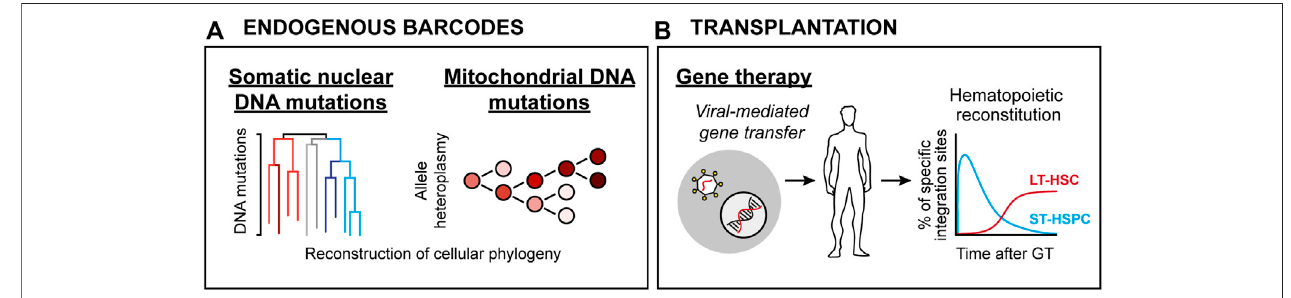
FIGURE 2 | HSC lineage tracing techniques in humans. (A) Endogenous clonal HSC lineage tracing. Here, de fi ned blood cell types are interrogated for either spontaneousnuclearmutationpatterns( Left )ormitochondrialDNAheteroplasmy( Right ),allowingforretrospectivephylogenicreconstructionandquanti fi cationofclonal